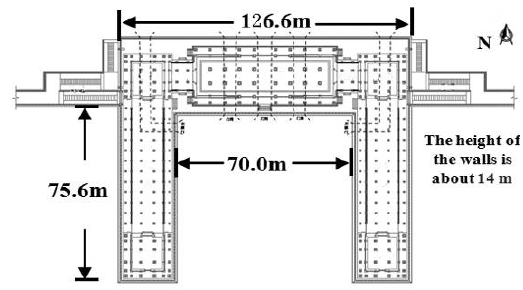
Figure5. The Architectural Drawing of the Wumen Circumvallation